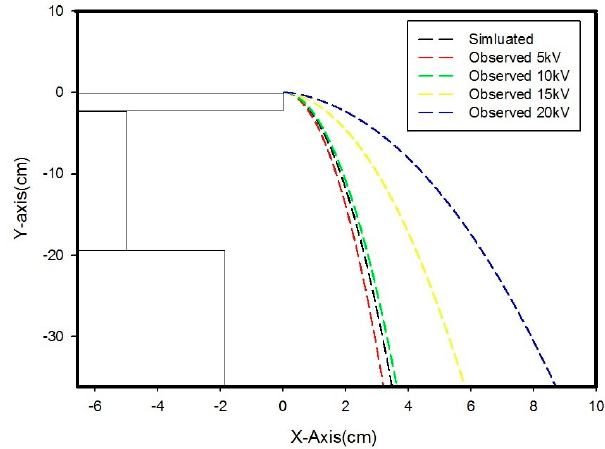
Figure 11. Comparison of non-conductive particle trajectory by observation vs. simulation. (Applied voltage (U): 20 kV, initial speed (v 0 ): 0.13 m · s − 1 , distance between two electrodes (L): 0.6 m).